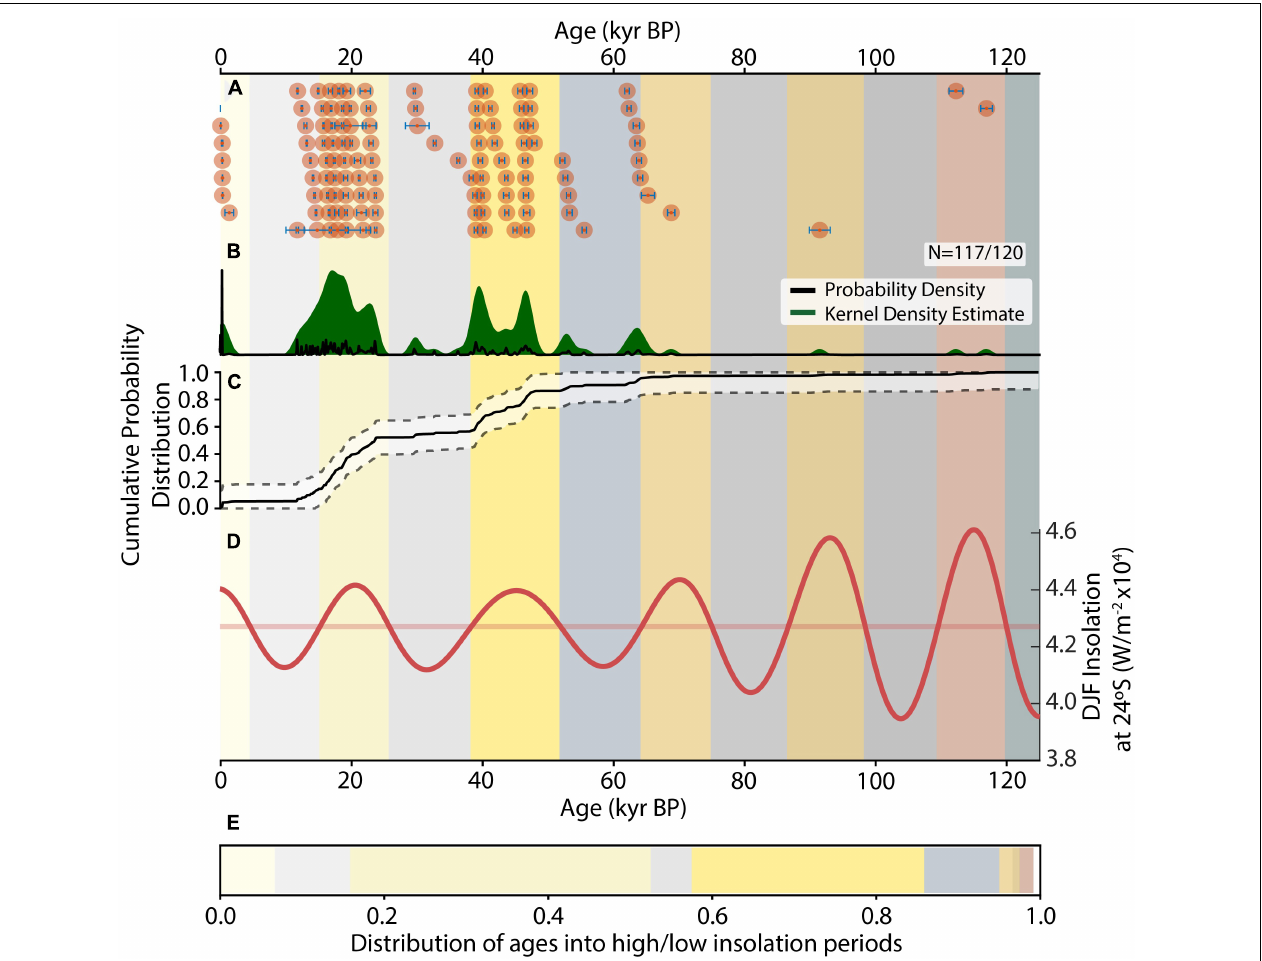
FIGURE 2 | Age distribution of stalagmites from TNP through time. (A) Individual U-Th ages (red dots) and 2 σ uncertainty (blue bars) based on 117 of 120 dated samples, (B) Probability density function of age distributions (black line) and kernel density estimate (green shading). (C) Cumulative probability distribution of U-Th age distributions with error. The fluctuating gradient highlights relative periods of excess and deficient speleothem growth relative to the idealized smooth exponential distribution of stalagmite age distributions with time (Scroxton et al., 2016). (D) Integrated summer (December–January–February, or DJF) insolation at 24 ◦ S (bold red line), and mean value (pale red line). Vertical color bars indicate periods with higher than mean insolation (yellows, darkening with time), and lower than mean insolation (grays, darkening with time). (E) Distribution of ages into high/low insolation periods following the color scheme above. Probability Density and Kernel Density Estimate curves determined using the detritalPy Python package (Sharman et al., 2018), with a fixed optimized kernel bandwidth and Dvoretsky-Kiefer-Wolfowitz inequality error estimates on the cumulative probability function. Insolation curves from The Climate Data Toolbox for MATLAB